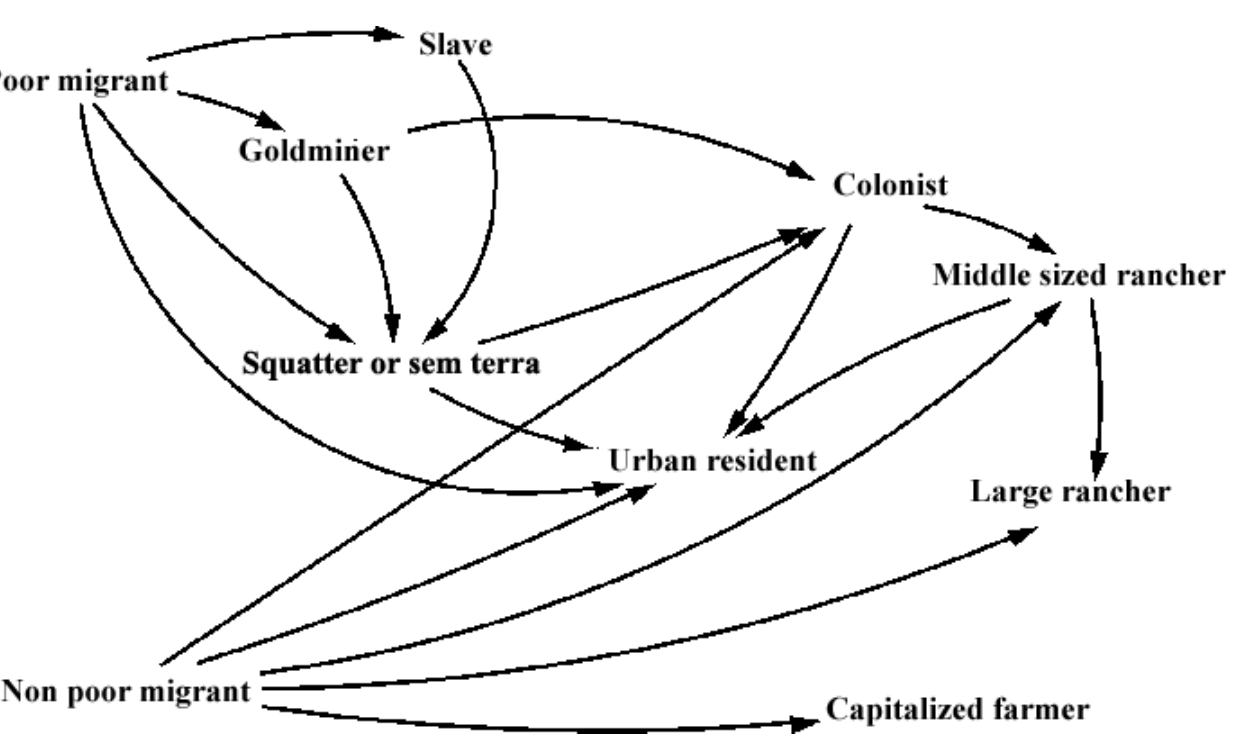
Fig. 5. Population: transformations over time of a given individual or